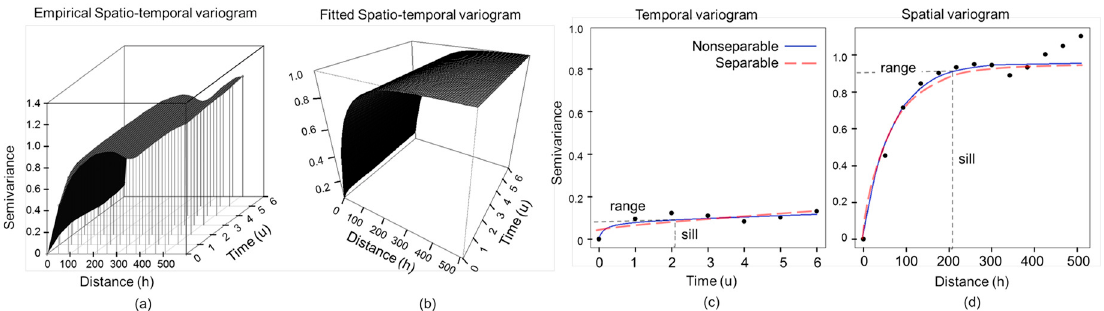
Figure 9. Spatiotemporal variograms for band 45 (862.01nm). ( a ) 3D empirical variogram. ( b ) 3D fitted variogram. ( c ) Fitted separable and non-separable temporal variogram. ( d ) Fitted separable and non-separable spatial variogram.